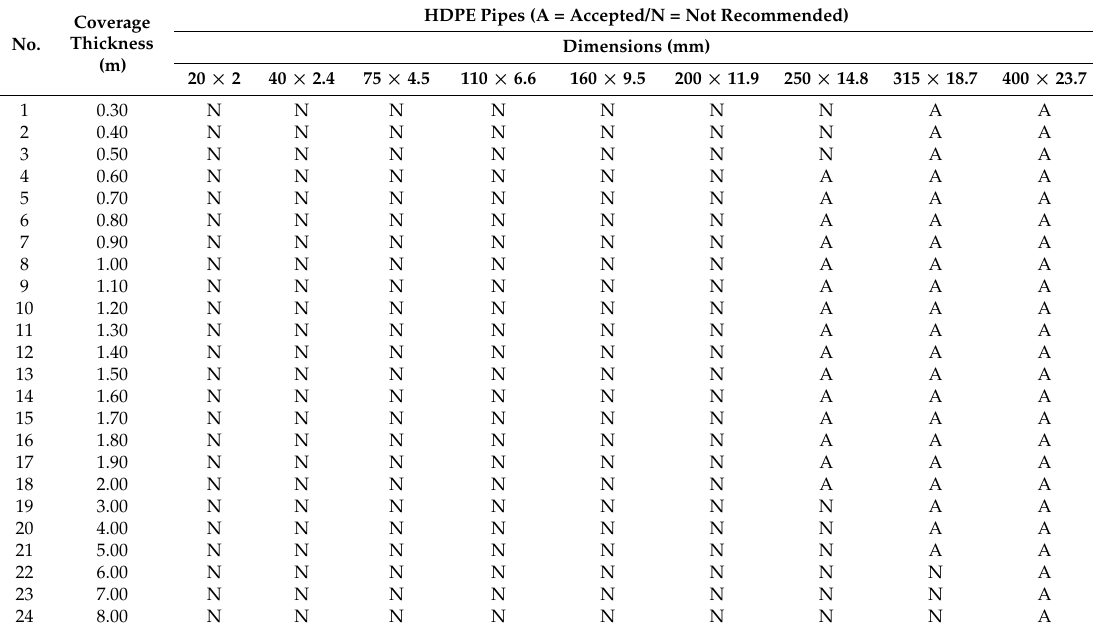
Table 14. Results of the calculations for the HDPE